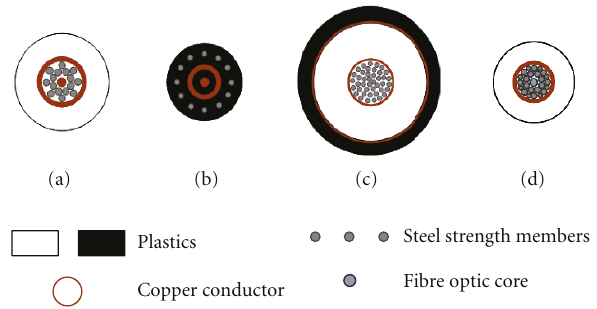
Figure 1: Cross-sections of the four cables used in the experiments.